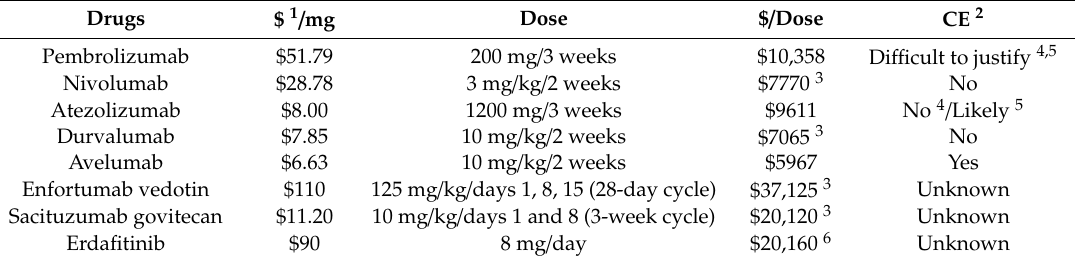
Table 3. Pricing for ICIs and targeted